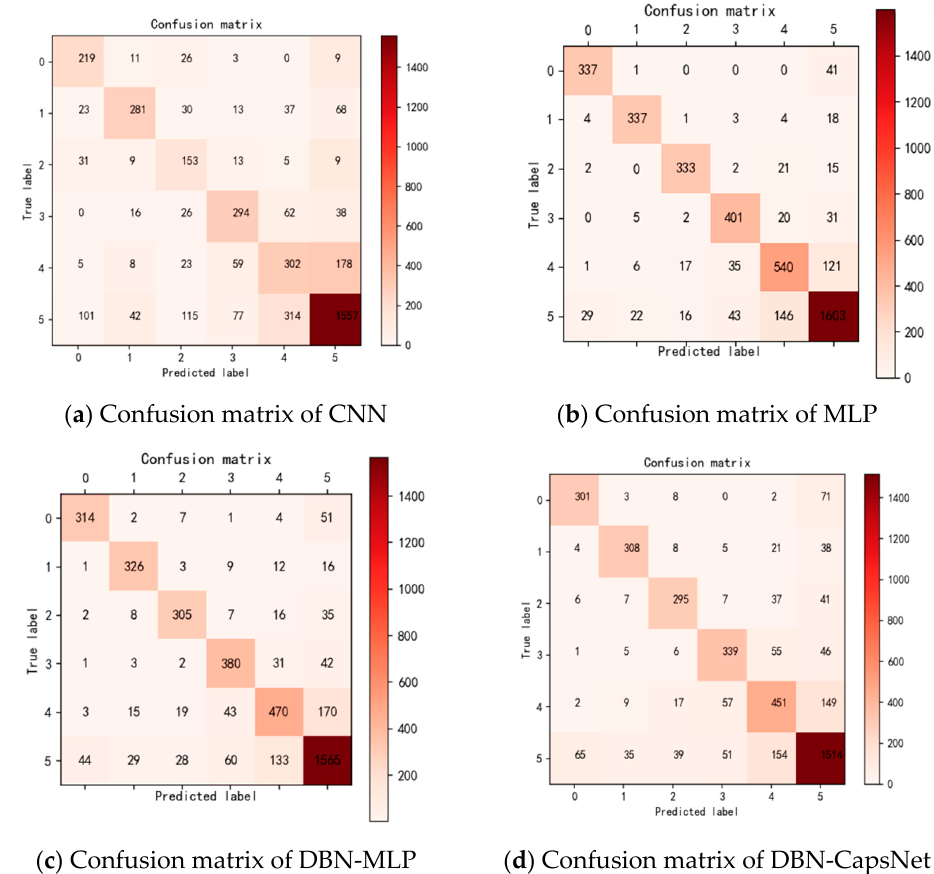
Figure 8. Comparison of four model confusion matrices. Table 2. The precision rate, recall rate, and F value of MLP, CNN, and DBN-MLP.